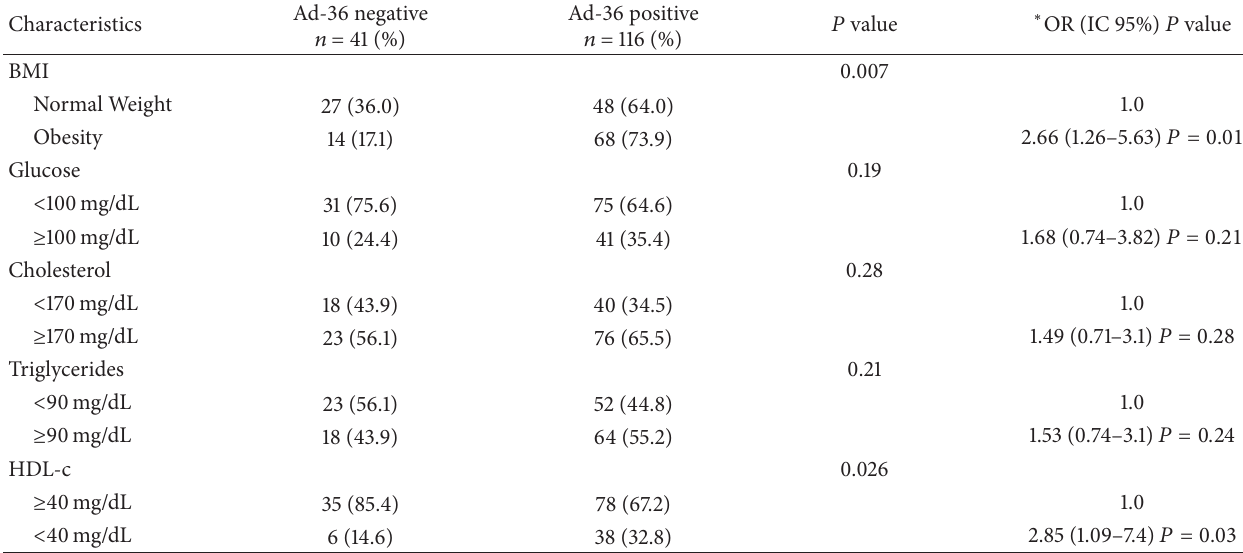
Table 3: Association of Ad-36 seropositivity with metabolic abnormalities.